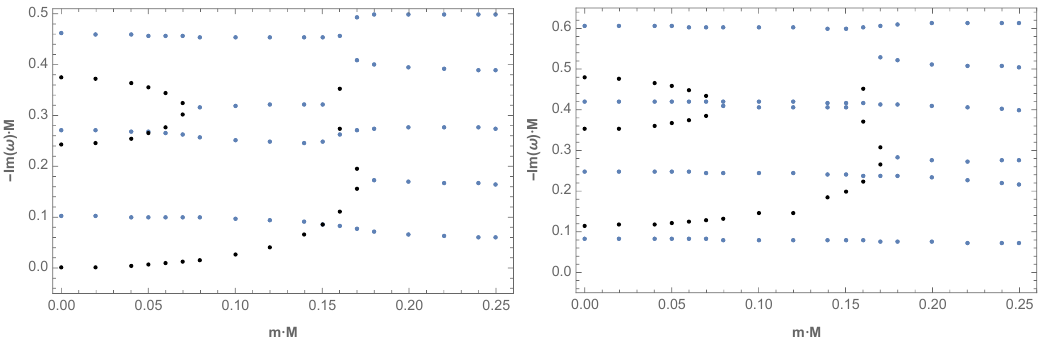
Figure 1 . The behaviour of the imaginary part of the quasinormal frequencies Im ( ω ) M as a function of the uncharged scalar field mass mM for different overtone numbers with Q/M = 1 / 10 , Λ M 2 = 0 . 04 , and ‘ = 0 (left panel), ‘ = 1 (right panel). Black points for purely imaginary QNFs and blue points for complex